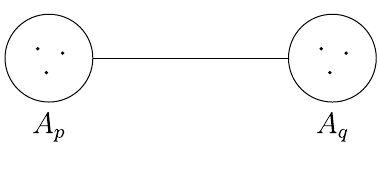
Figure 3: G 2 when n pq =